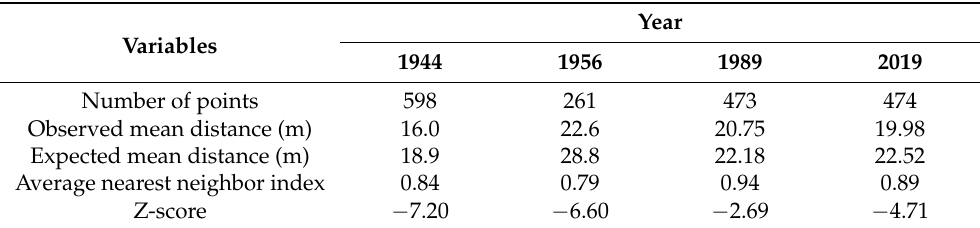
Table 3. Statistics of the distance to the nearest neighbor for buildings in the central area of W˛e- gorzewo between 1944 and